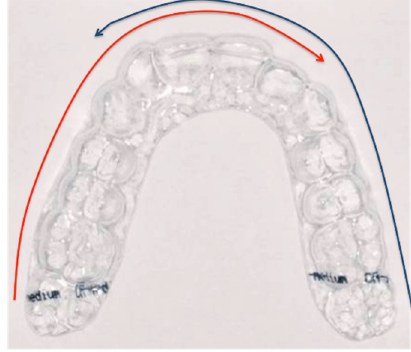
Figure 1. Path of the scanning technique.